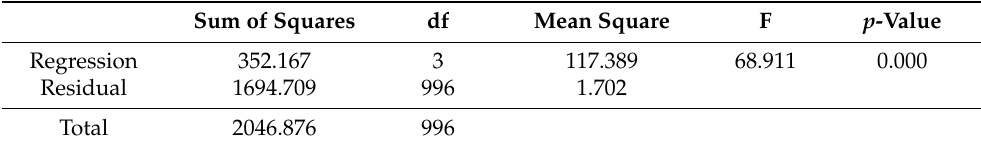
Table 10. ANOVA regression analysis.